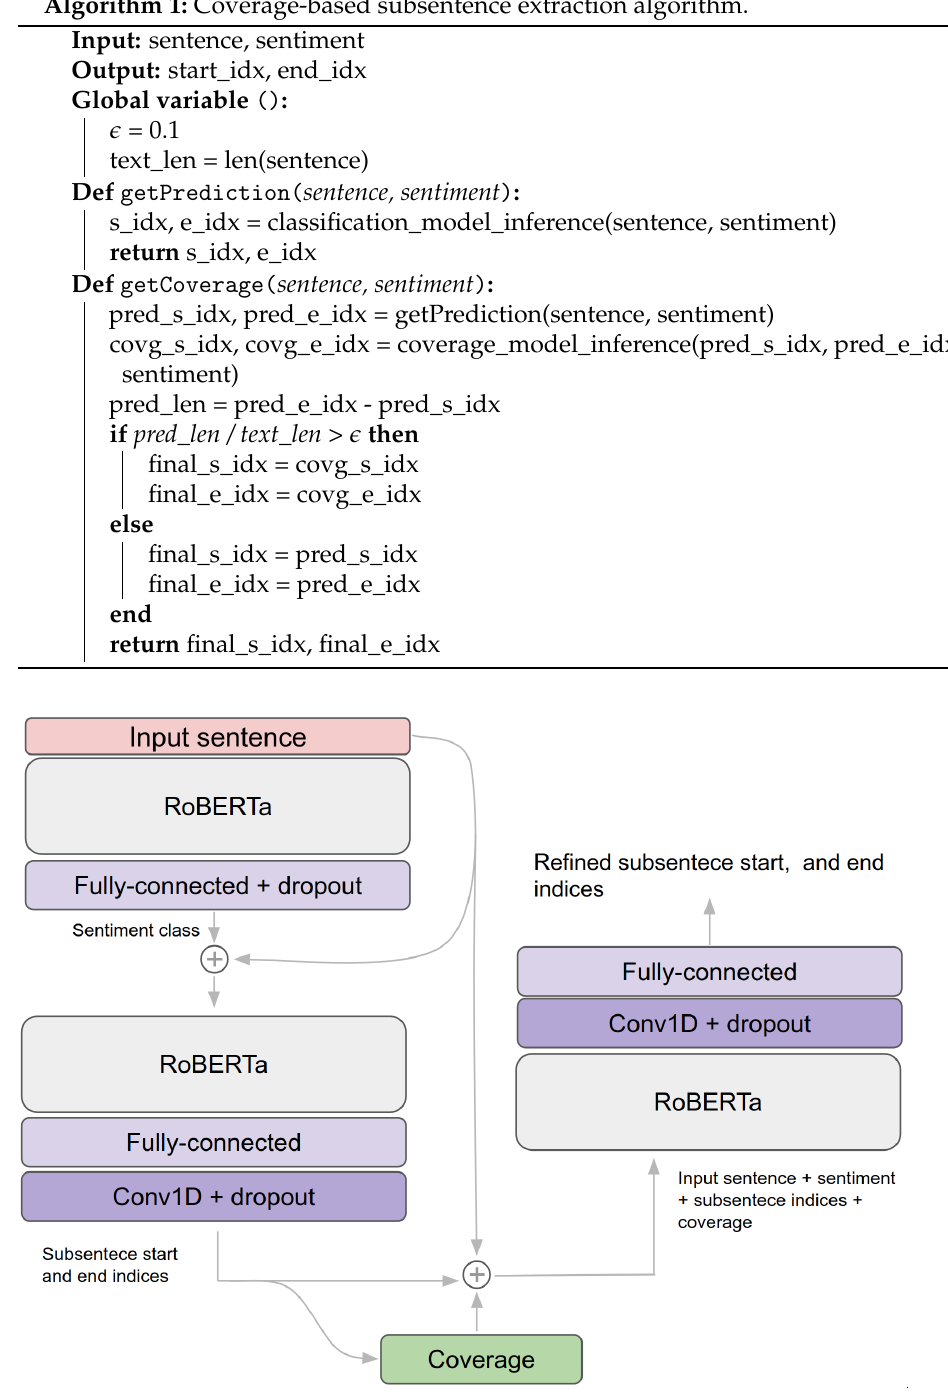
Figure 4. Coverage-base subsentence extraction network architecture and pipeline. This is an in-depth representation of Figure 1 with data